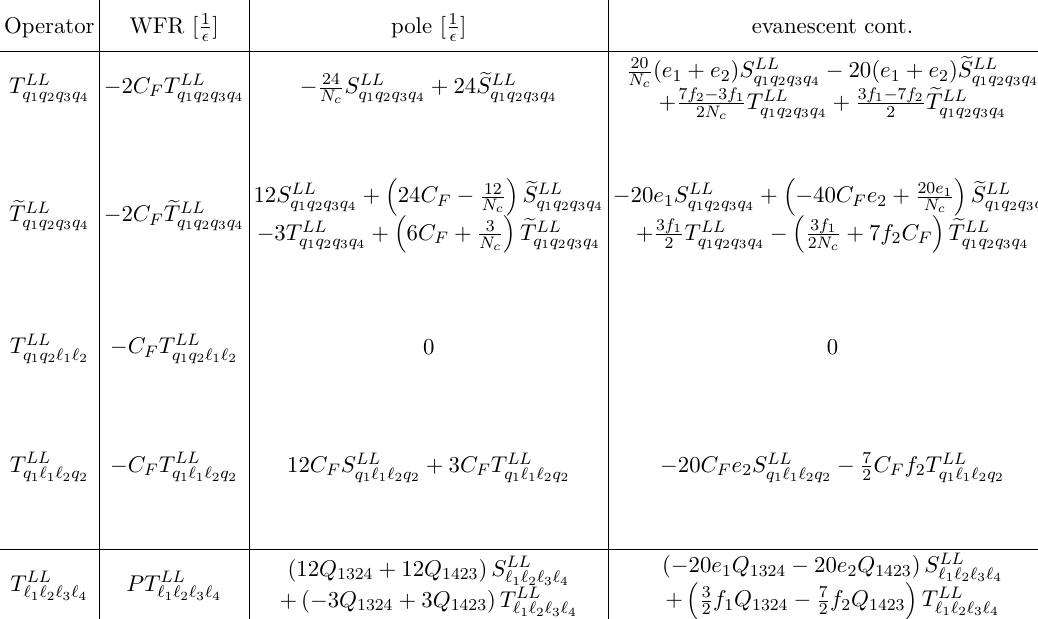
The same relations hold if the basis { V LL difference that Z (1 , 0)